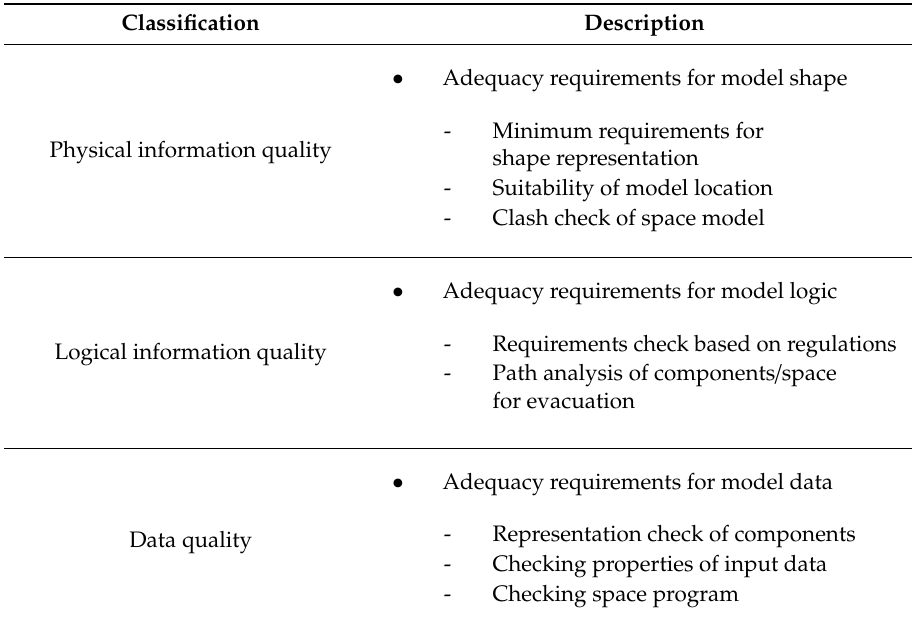
Table 1. Classification of quality control based on building information modeling